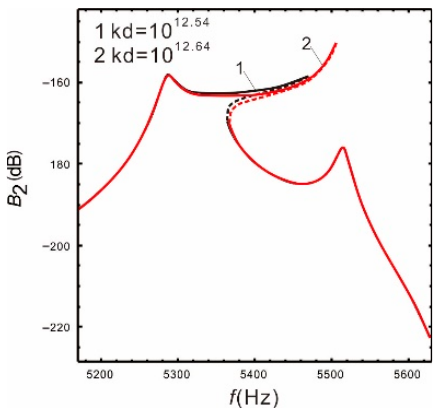
Figure 9. ∆ = 230 Hz .